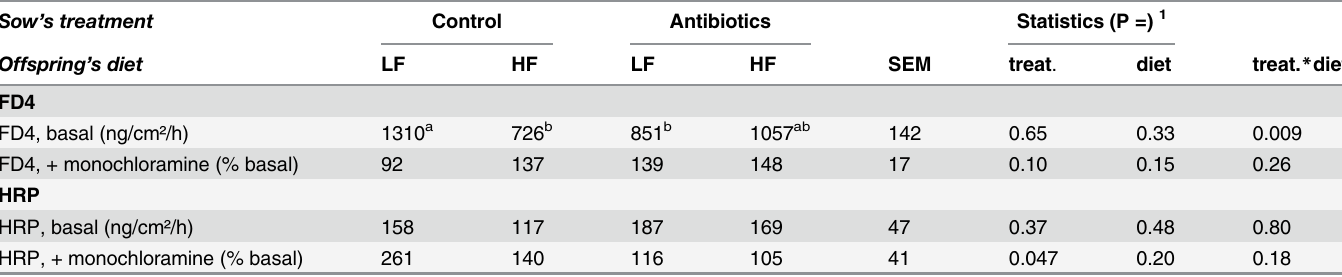
Table 2. Mucosal-to-serosal fl uxes of FD4 and HRP for basal and monochloramine-stimulated colonic mucosa of pigs born to control or antibiotic-treated sows and fed a low (LF) or a high (HF) fat diet between 140 and 169 days of age (LSmeans and SEM, n = 8 – 10 per treatment). Sow ’ s